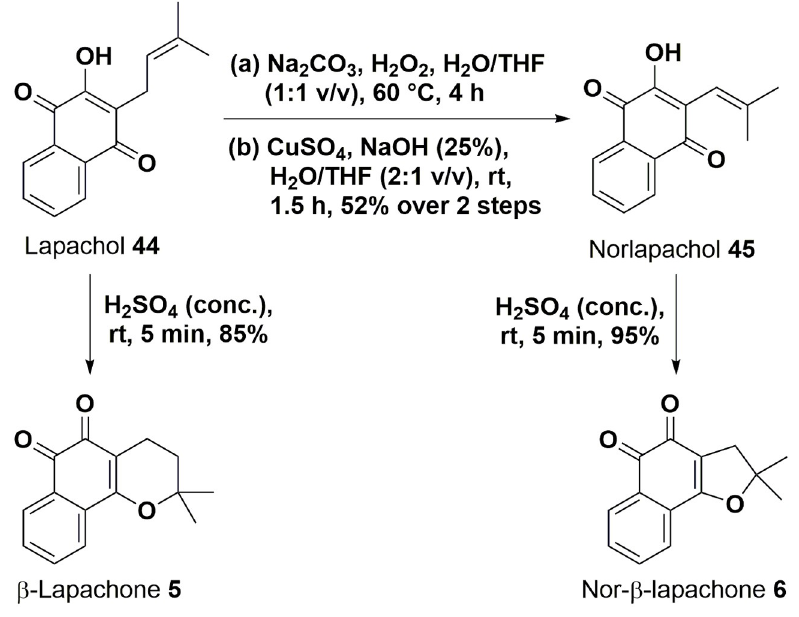
Fig 5. Synthesis of norlapachol 45 and β -lapachones 5, 6.